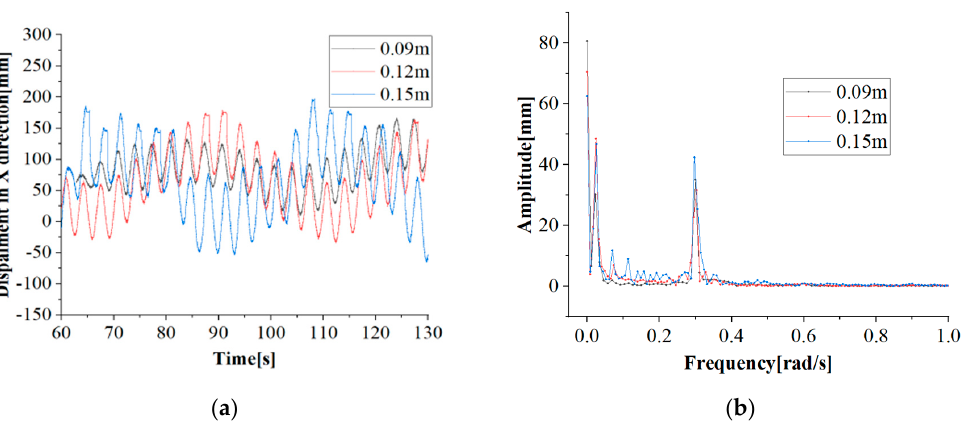
Figure 15. Surge response of the pedestal with different wave heights at 0.30 Hz. ( a ) Surge; ( b ) surge frequency domain curve.